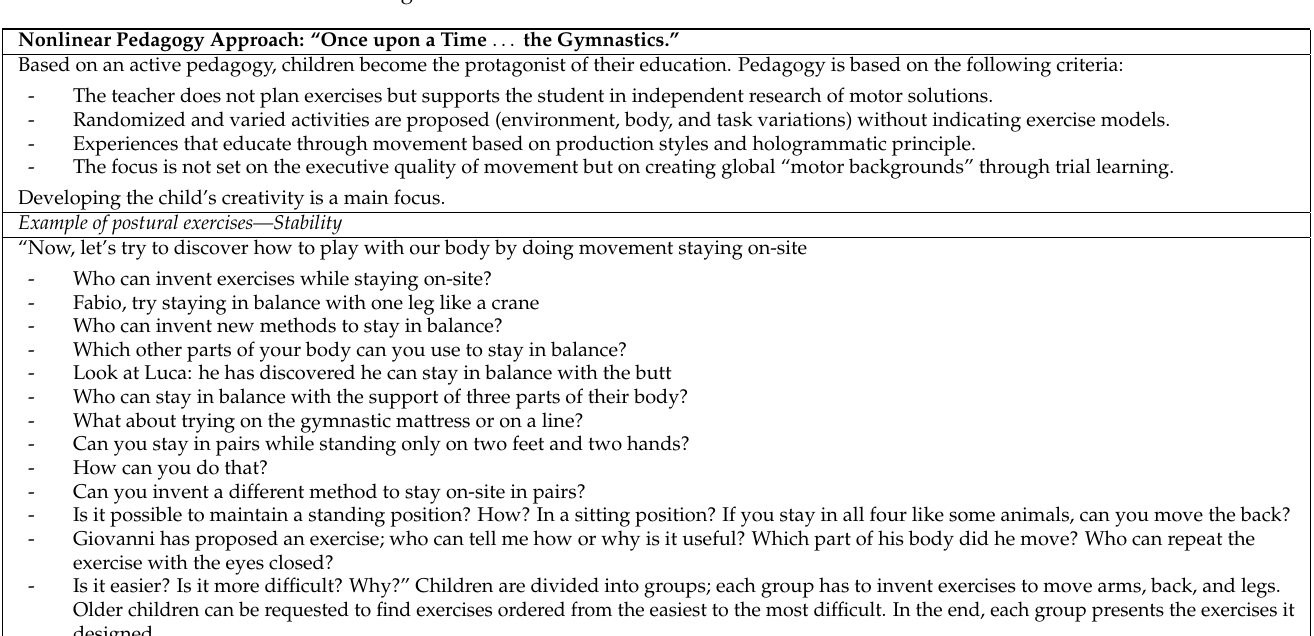
Table A3. An example of the structured practice prevalently based on nonlinear pedagogy, as used in teaching